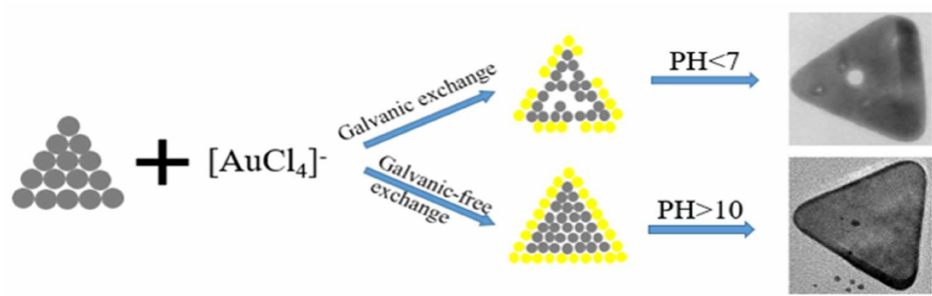
Scheme 1. The schematic illustration of the preparation of triangular Ag@Au nanoprisms.